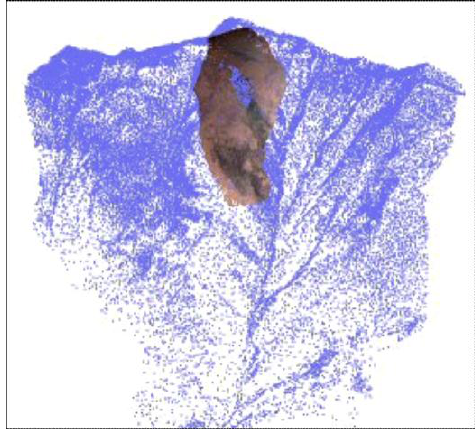
Figure 4. The area analyzed for volume